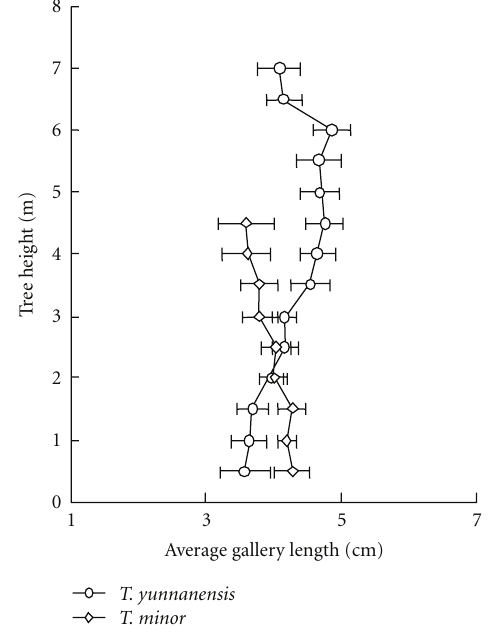
Figure 5: Average egg gallery length ( ± SE) of T. yunnanensis and T. minor along the trunks of Yunnan pines in November, 2005 (Qujing, Yunnan province,